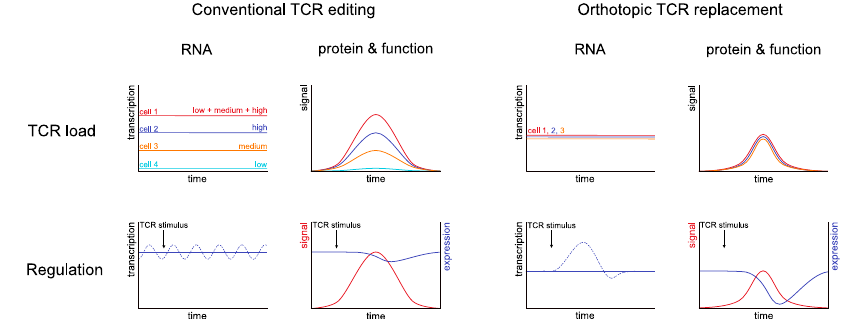
Figure 3. TCR RNA and protein levels and their impact on function after conventional editing versus OTR. Top left: Conventional TCR editing leads to random insertion of TCR DNA and, thus, expression of TCR RNA. Individual cells can harbor high or low expression of individual transcripts, or a combination of them, depending on the site of insertion and the copy number. This directly affects protein expression and TCR function. Bottom left: Upon insertion in non-TCR gene loci, baseline TCR transcript regulation may be more unstable (and, e.g., affected by “global” or “off-target” genetic regulation of the cell). Furthermore, regulation should not be affected by TCR stimulation, leading only to minor shifts in TCR protein expression (as experimentally shown in References [25,26]). Top right: Upon OTR, transgenic TCR insertion is highly defined, leading to defined protein expression and cellular function. Bottom right: TCR RNA expression should be more affected by TCR stimulation after OTR. At the protein level, the initial more significant downregulation of TCR protein (as experimentally shown in Reference [26]) is followed by upregulation. While first experimental evidence exists for di ff erential TCR regulation upon OTR, the exact contribution of TCR insertion (copy number and integration site), RNA expression, and protein regulation will need to be delineated in detailed studies in the